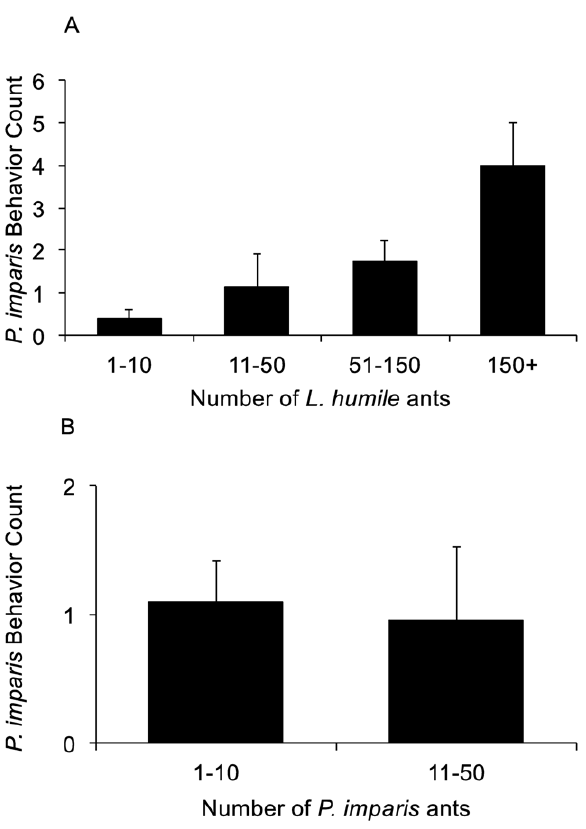
Figure 2. Aggressive interactions in field observations of P. imparis and L.humile . Shown are the mean numbers of aggressive interactions by A. L. humile density and B. P. imparis density. Error bars show standard error of the mean. Sample sizes in A were N =22 for 1– 10, N =16 for 11–50, N =4 for 51–150, and N =2 for 150 + . Sample sizes in B were N =21 for 1–10 and N =23 for